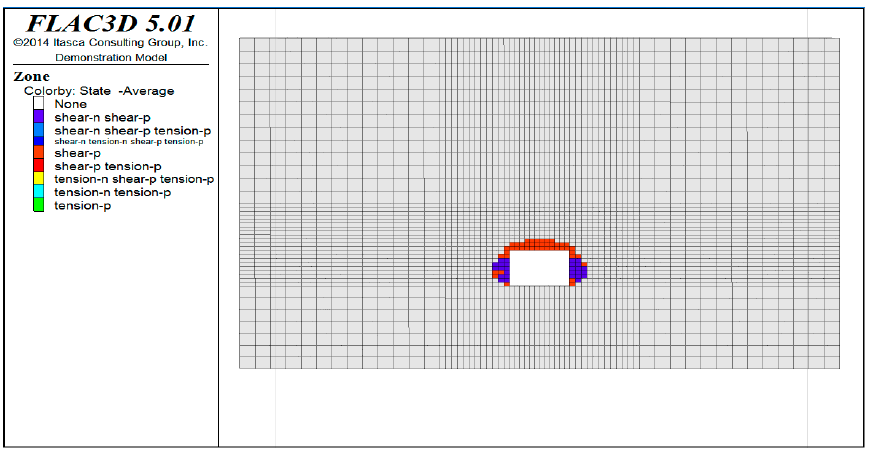
Figure 10. Distribution of plastic